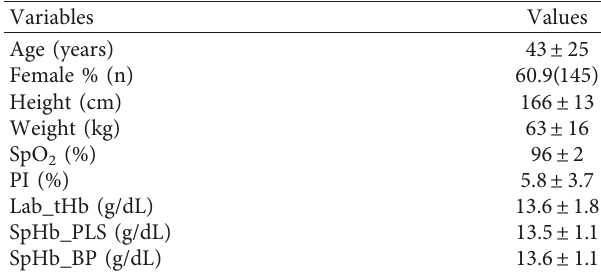
Table 1: Demographics and detected Hb values of the study population ( N �